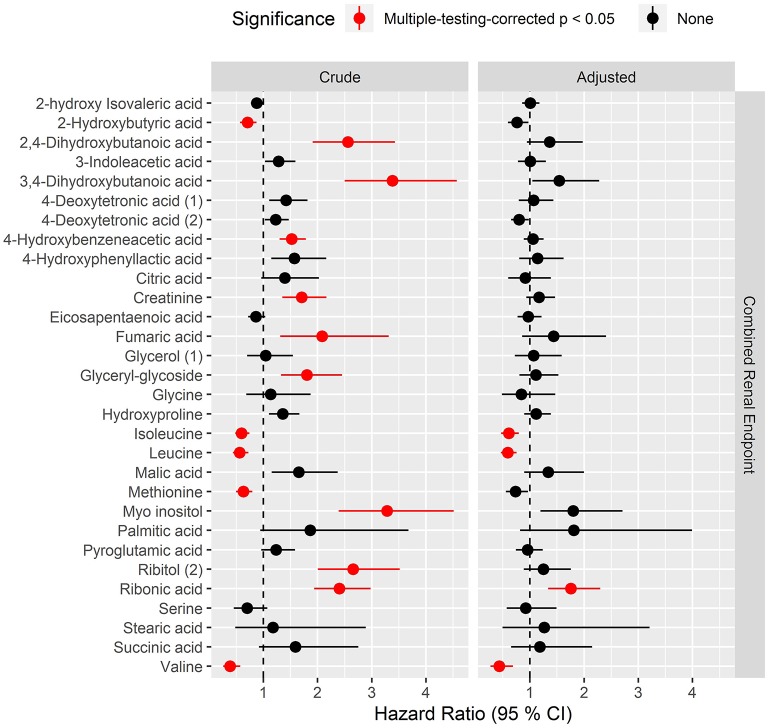
Hazard ratios of prioritized metabolites for progression to the combined renal endpoint. Hazard ratios (HRs) to the combined endpoint for metabolites that had pBH < 0.05 in any of the cross-sectional analyses. The combined renal endpoint includes ≥30% decrease in eGFR, ESRD and all-cause mortality with time to first event. HRs are presented per 1 SD increase of the log2 metabolite and are shown for crude model (left) and for model adjusted for age, sex, HbA1c, systolic blood pressure, smoking, body mass index, statin treatment, p-triglycerides, total p-cholesterol, eGFR and logUAER (right).